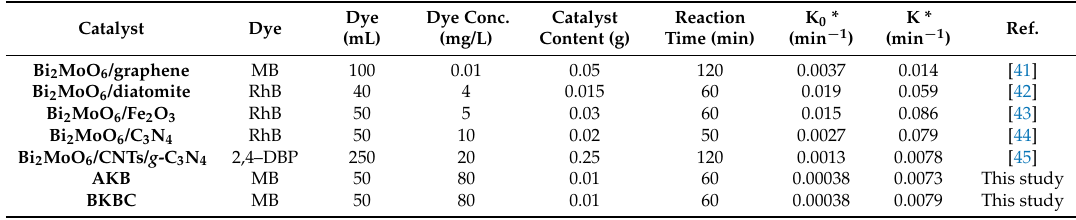
Table 5. Kapp values of different photocatalyst composites in literatures and this